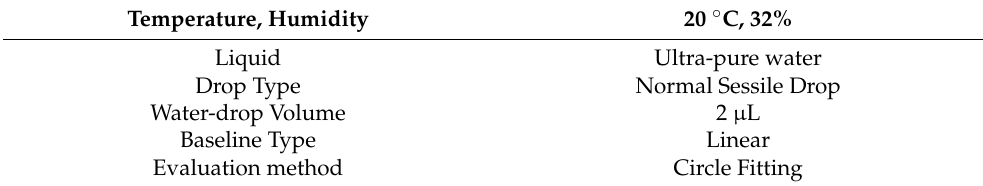
Table 1. Measurement conditions of the water contact angle of amorphous carbon films. Temperature,